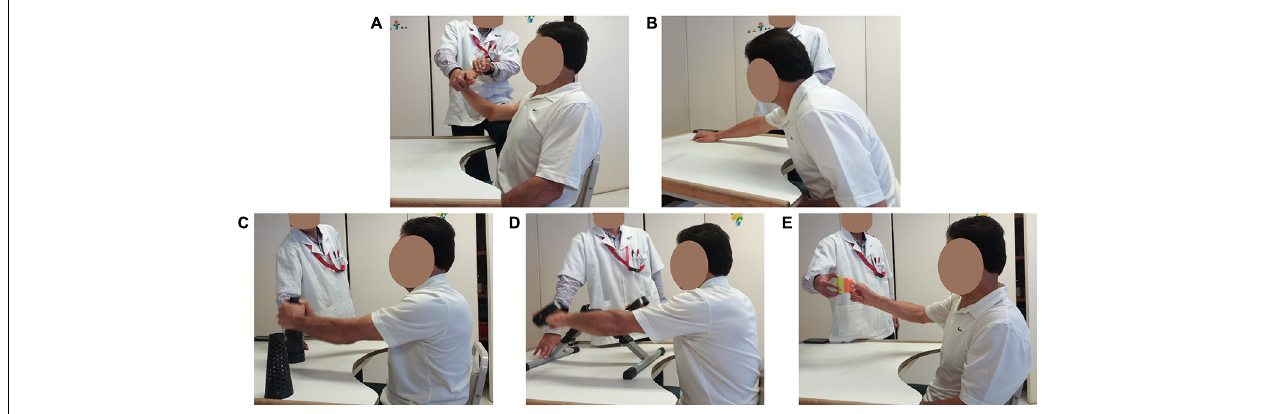
FIGURE 4 | Conventional therapy. (A) Finger and wrist stretching exercises. (B) Arm stretches. (C) Gross pinch and lifting objects. (D) Gross pinch and rotating arm exercise. (E) Fine pinch grip lifts.